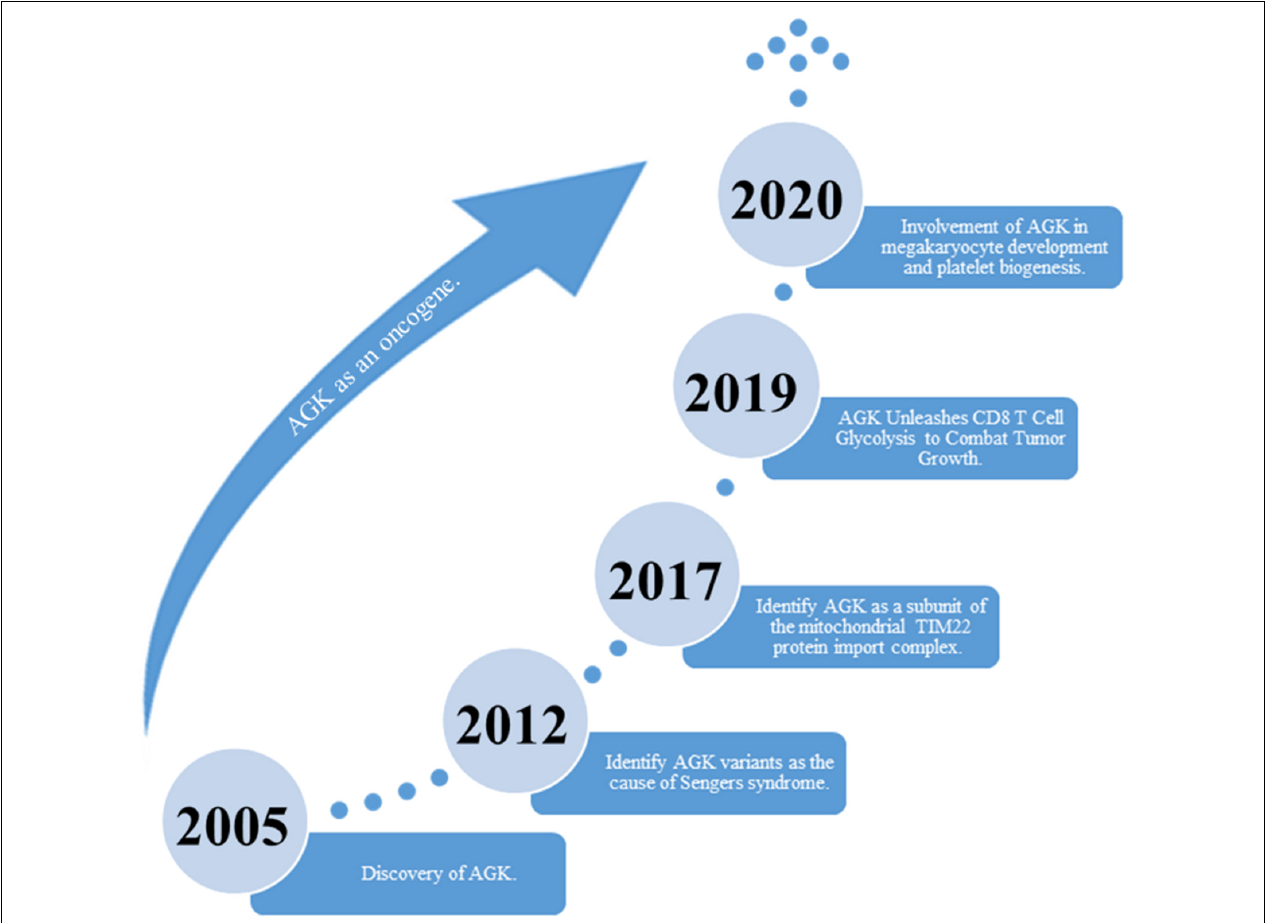
FIGURE 1 | The discovery of AGK’s historical